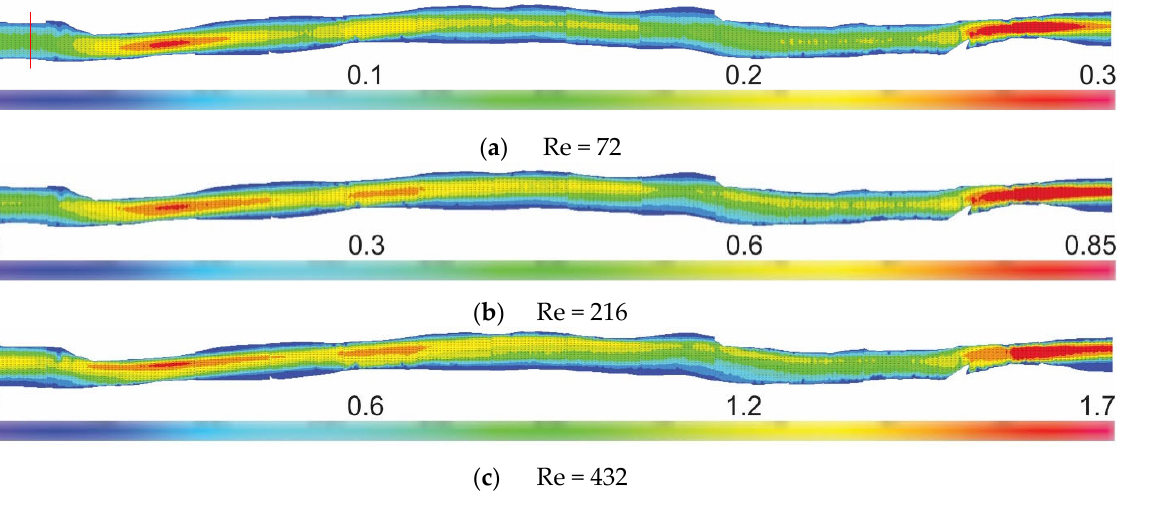
Figure 8. Vector statistics and velocity magnitudes (m/s) along the whole blood vessel for different Re numbers. The red line in ( a ) shows the place where the Reynolds numbers were calculated.